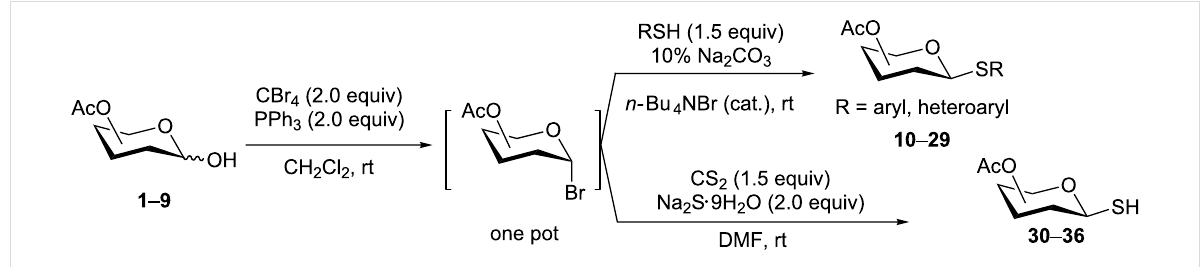
Scheme 1: Appel-reagent-mediated transformation of glycosyl hemiacetal derivatives into thioglycosides and β -glycosyl thiol derivatives in one